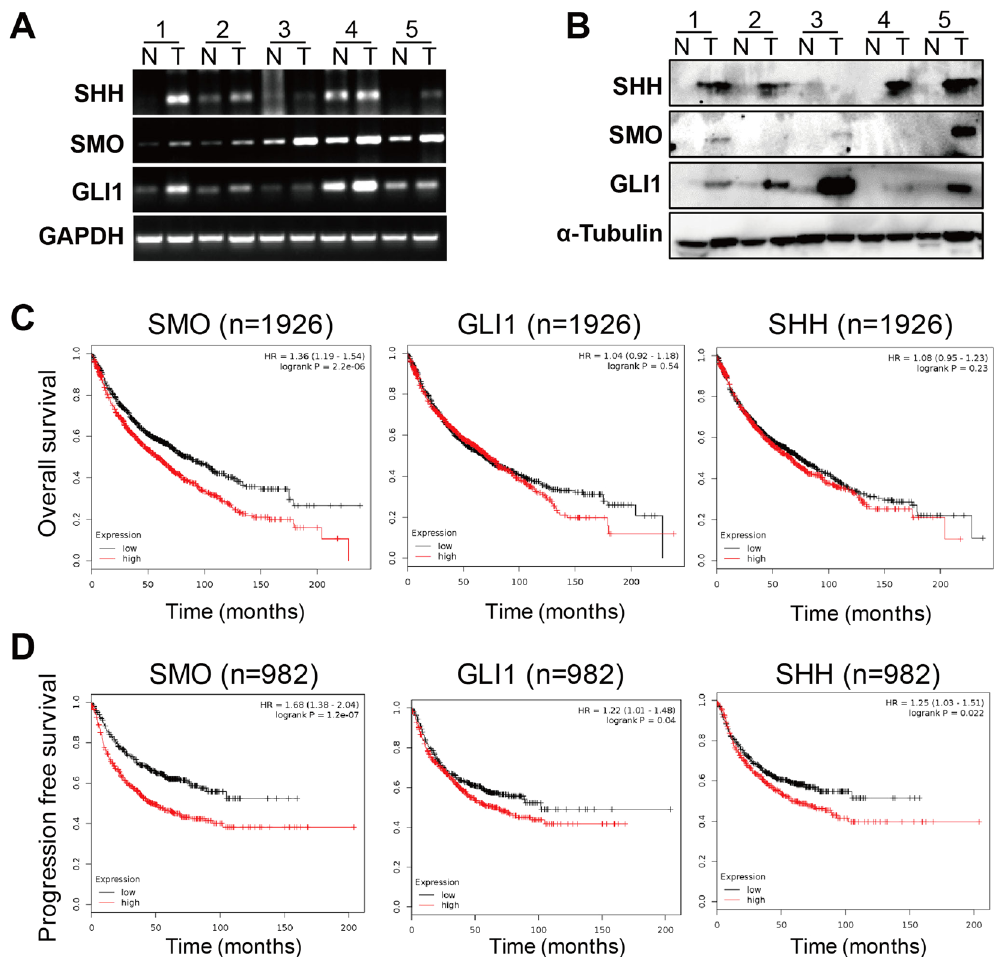
Figure 1. Aberrant activation of SHH signaling in lung tumors from patients with adverse prognosis. ( A ) RT-PCR analysis of the endogenous mRNA levels of SHH, SMO and GLI1 in human lung cancers relative to paired normal lung tissues. GAPDH was amplified in parallel as inner control. N and T represent normal and tumor specimens separately. ( B ) Immunoblotting analysis of the endogenous protein levels of SHH, SMO and GLI1 in human lung cancers relative to paired normal lung tissues. α -Tubulin was loaded as inner control. ( C ) Kaplan Meier overall survival (OS) curves of SMO (left, n = 1926, p = 2.2E-06 by log-rank test for significance), GLI1(middle, n = 1926, p = 0.54 by log-rank test for significance) and SHH (right, n = 1926, p = 0.23 by log- rank test for significance). ( D ) Kaplan Meier progression free survival (PFS) curves of SMO (left, n = 982, p = 1.2E-07 by log-rank test for significance), GLI1(middle, n = 982, p = 0.04 by log-rank test for significance) and SHH (right, n = 982, p = 0.022 by log-rank test for